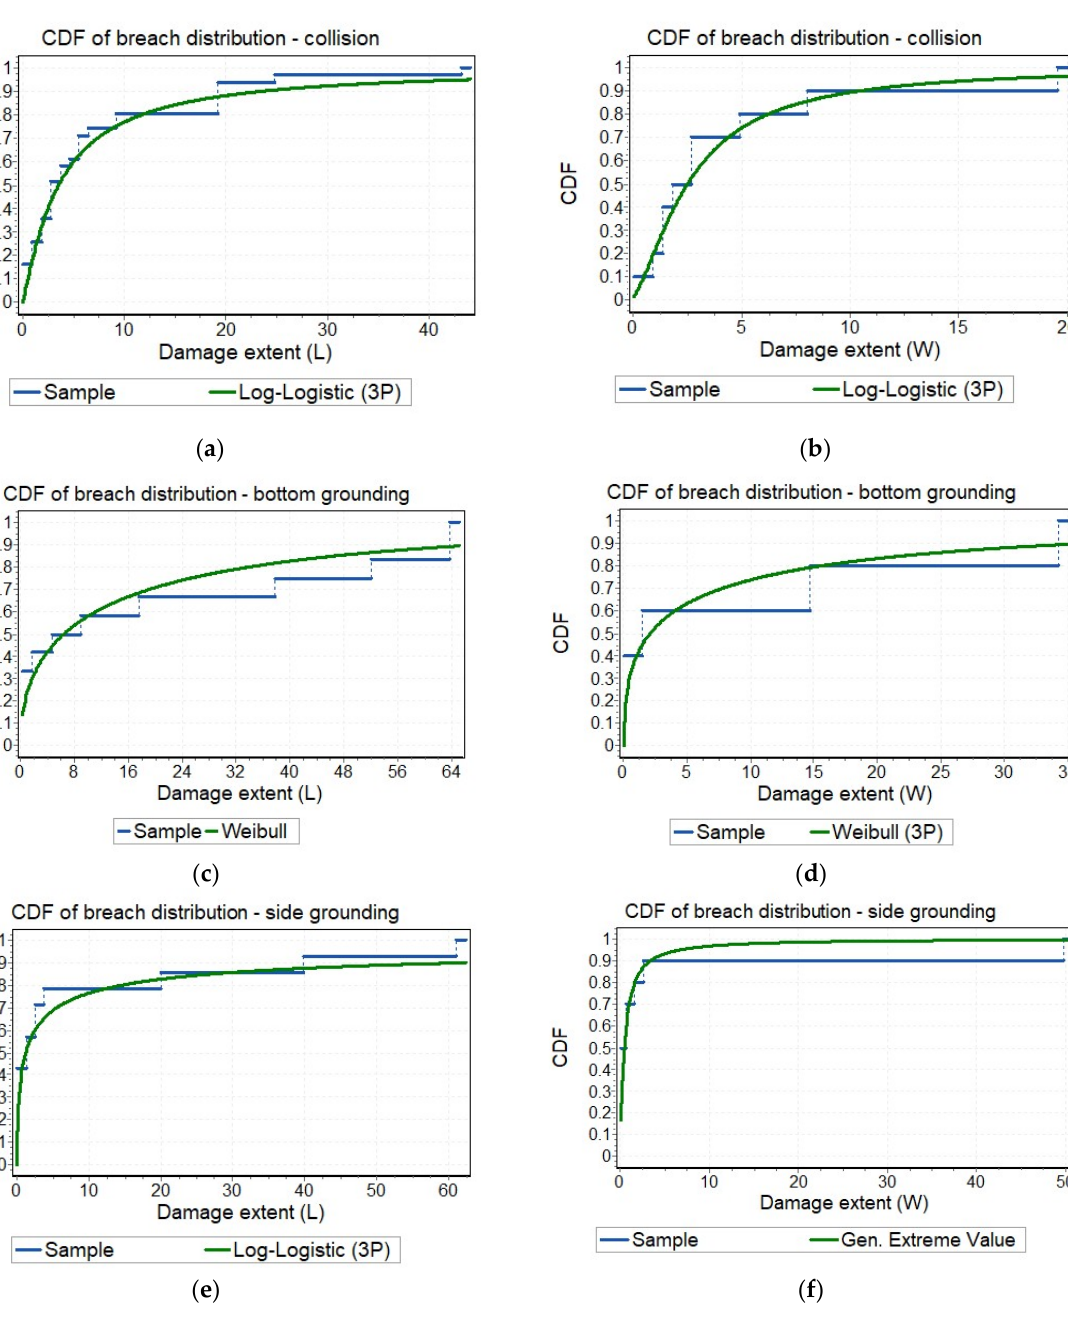
Figure 18. ( a ) CDF of damage length (L) for collision; ( b ) CDF of damage width (W) for collision; ( c ) CDF of damage length (L) for bottom grounding; ( d ) CDF of damage width (W) for bottom grounding; ( e ) CDF of damage length (L) for side grounding; ( f ) CDF of damage width (W) for side grounding.